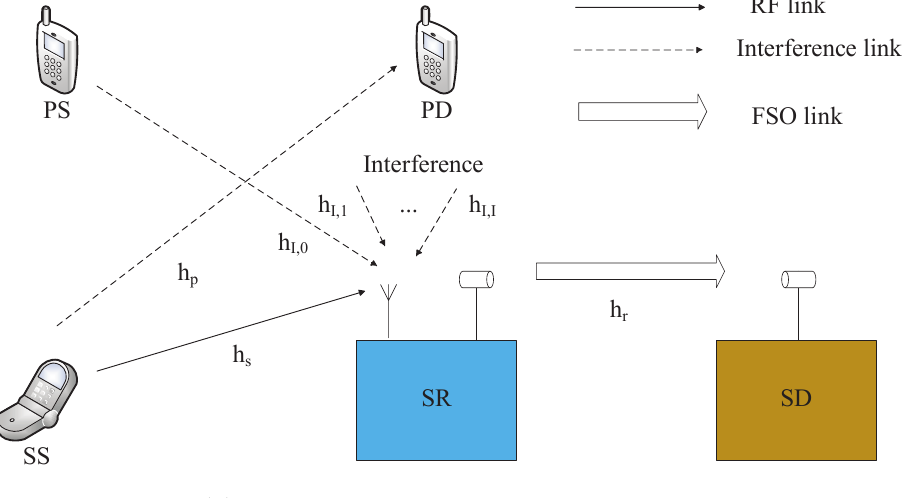
Figure 1. System